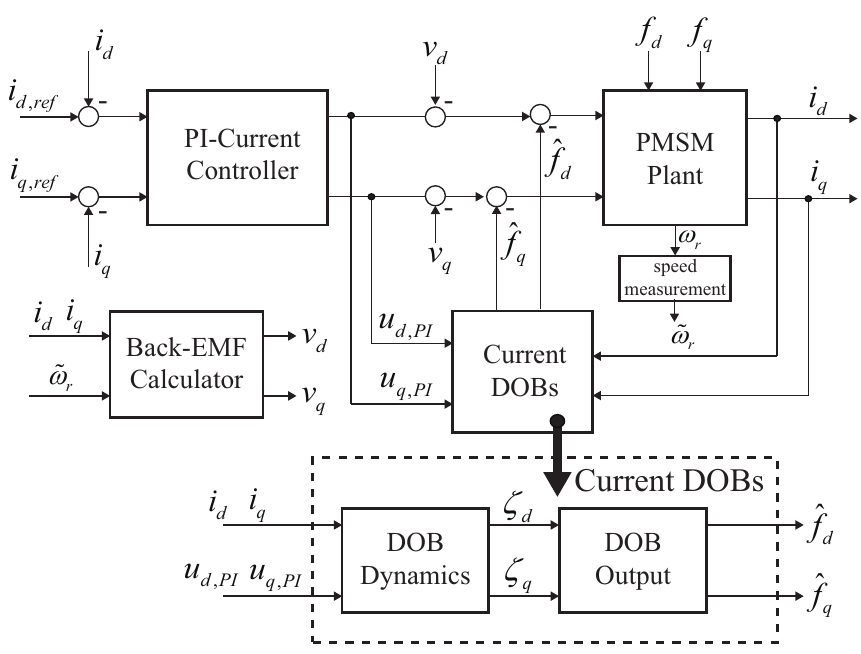
Figure 4. Proposed current control algorithm structure. DOB: disturbance